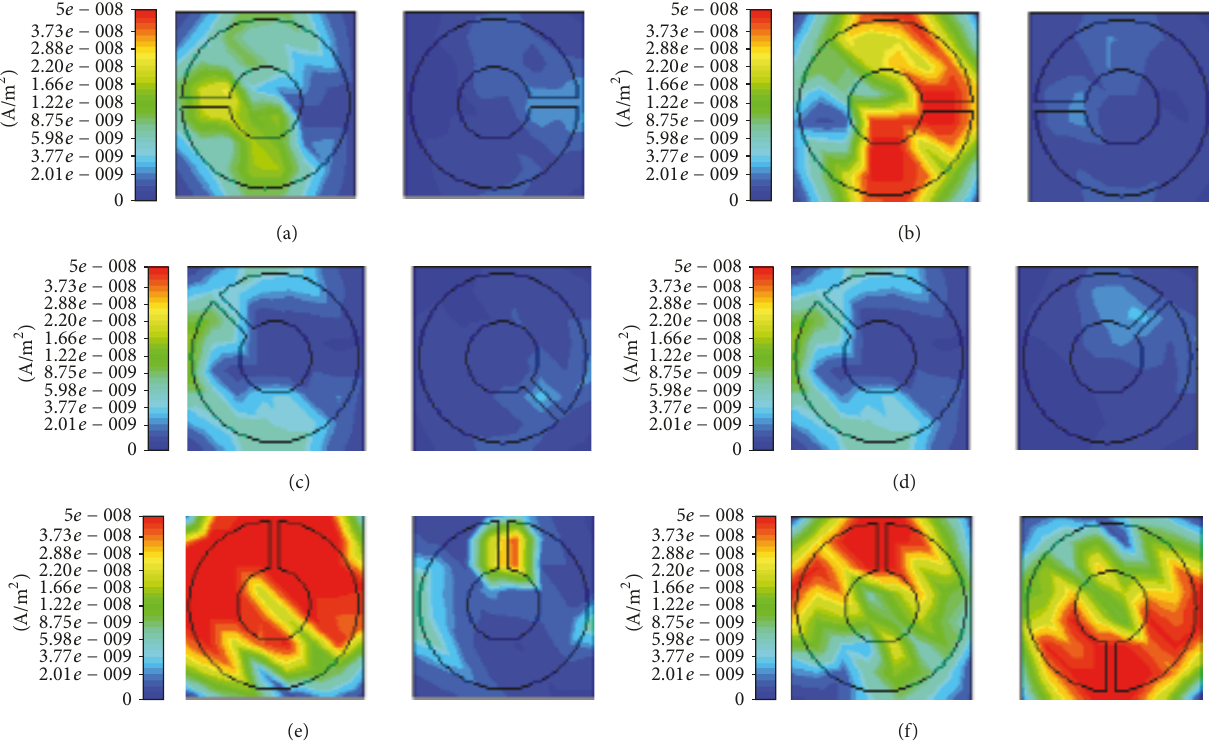
Figure 7: Different orientation of two rings: (a) 180 ∘ and 0 ∘ , (b) 0 ∘ and 180 ∘ , (c) 135 ∘ and − 45 ∘ , (d) 135 ∘ and 45 ∘ , (e) 90 ∘ and 90 ∘ , and (f) 90 ∘